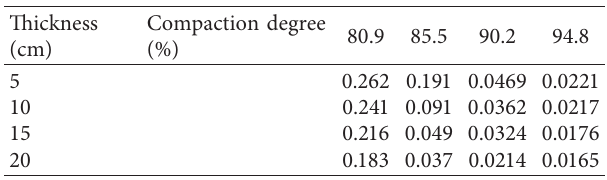
Figure 3: Device structure design. (a) Schematic diagram. (b) Table 3: Radon exhalation rate after covering different attribute soils.